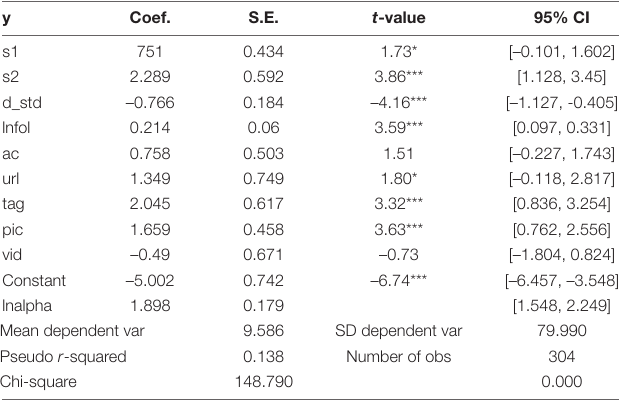
TABLE 3 | Negative binomial regression results: sample 1.